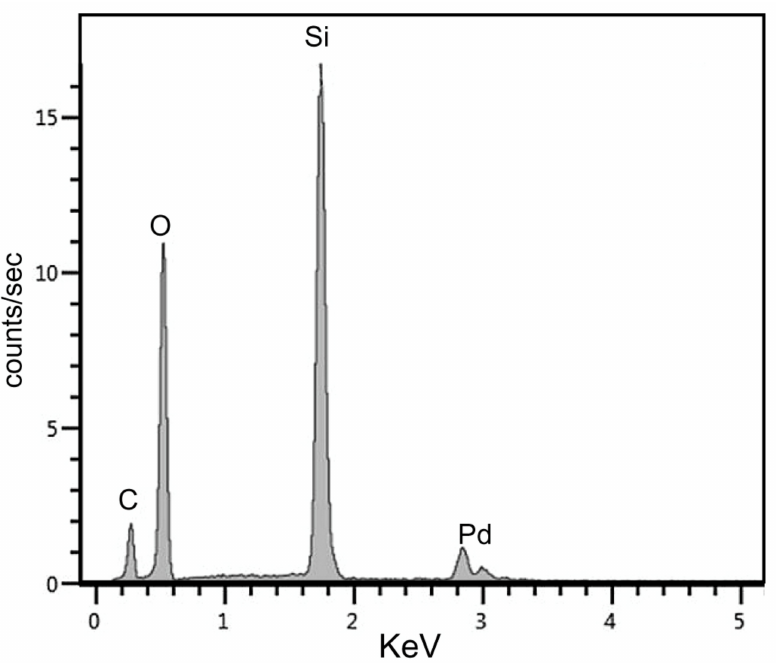
Figure 18. SEM/EDS spectrum of Miocene silicified wood from Meshgin Shar area, northwest Iran [75]. The small carbon peak is evidence that very little of the original organic material was preserved during fossilization. The Pd peak is from a thin palladium coating applied to the specimen surface to provide electrical